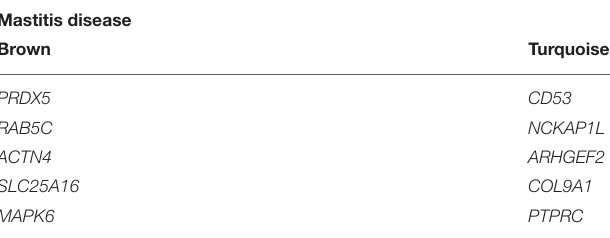
TABLE 5 | Top hub genes in significant modules in mastitis disease.